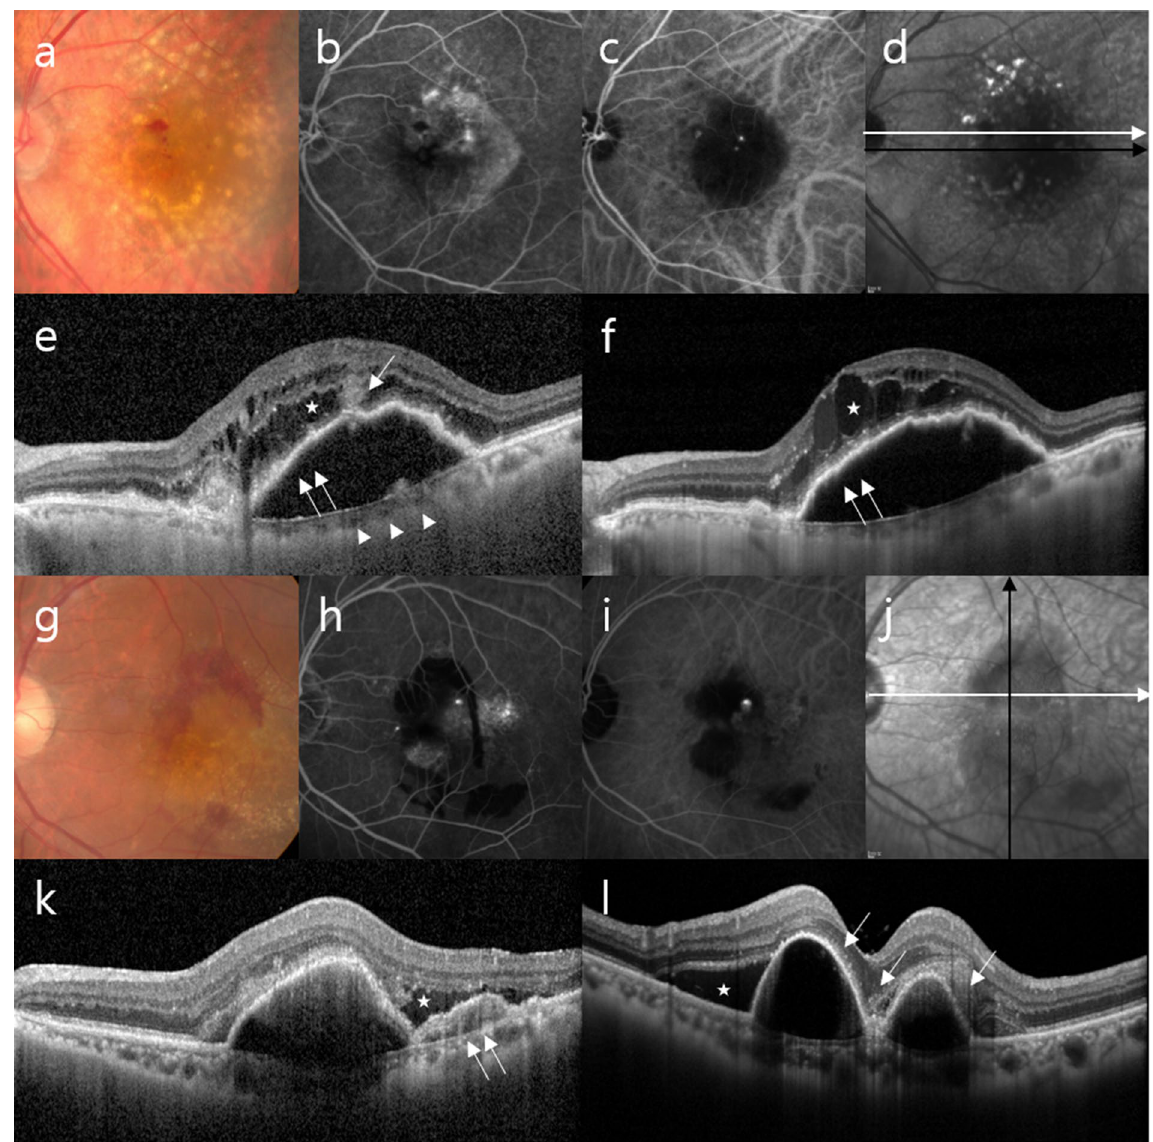
Figure 4. Representative cases of RAP and PCV. ( a – f ) RAP. ( a ) Fundus photography, ( b ) FA, ( c ) ICGA, ( d ) infrared reflectance, and ( e , f ) OCT images of an eye with RAP. The OCT images ( e , f ) show typical features of RAP: a thin choroid (arrowheads), intraretinal cyst-like fluid accumulation (asterisks), absence of subretinal fluid, trapezoid-shaped RPED (double arrows), and the presence of an intraretinal-subretinal continuous hyperreflective lesion with a break in the RPE (arrow). The white and black arrows in the infrared reflectance image ( d ) indicate the OCT scanning lines for the images ( e ) and ( f ), respectively. ( g – l ) PCV. ( g ) Fundus photography, ( h ) FA, ( i ) ICGA, ( j ) infrared reflectance, and ( k , l ) OCT images of an eye with PCV. The OCT images ( k , l ) show irregular retinal pigment epithelium elevation with double-layer sign (double arrow), subretinal fluid (asterisks), and sharp-peaked or steeper dome-shaped RPEDs or notches (arrows). The white and black arrows in the infrared image ( j ) indicate the OCT scanning lines for the images ( k ) and ( l ), respectively. FA, fluorescein angiography; ICGA, indocyanine green angiography; OCT, optical coherence tomography; PCV, polypoidal choroidal vasculopathy; RAP, retinal angiomatous proliferation; RPE, retinal pigment epithelium; RPED, retinal pigment epithelial